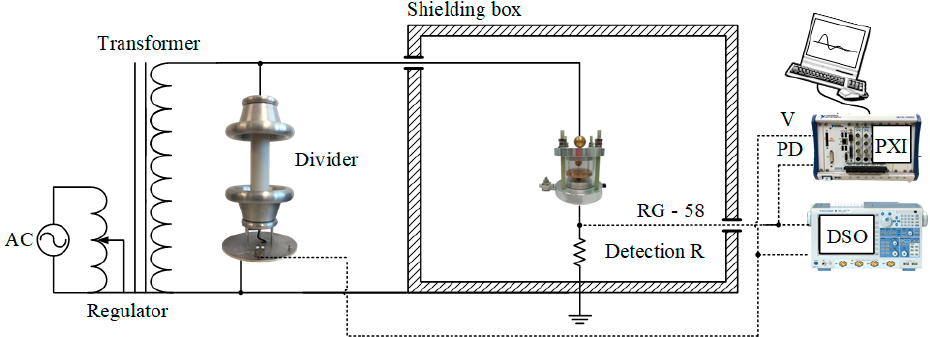
Figure 1. Configuration of experimental setup. PD: partial discharge; DSO: digital oscilloscope; PXI: peripheral component interconnect eXtensions for instrumentation.